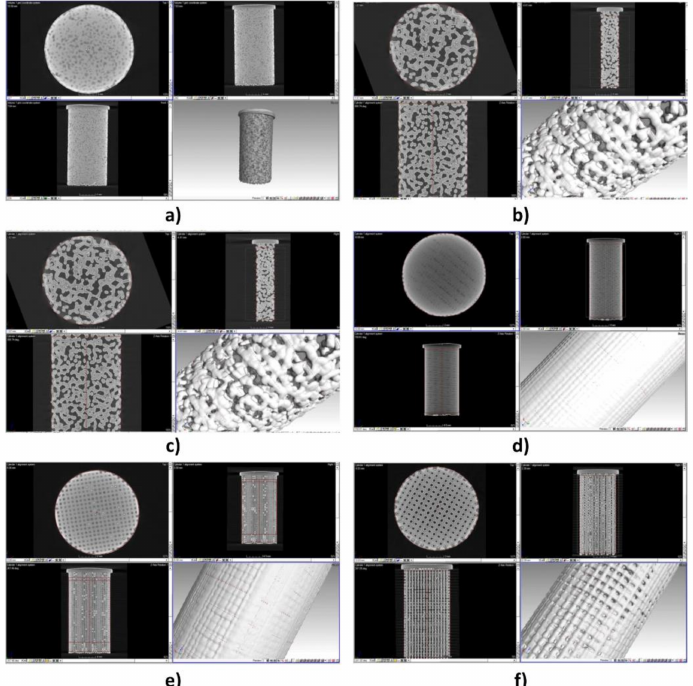
Figure 7. 3D scans of the tested specimens taken by PC-tomography ( a ) trabecular with 200 µ m pore size, ( b ) trabecular with 400 µ m pore size, ( c ) trabecular with 600 µ m pore size, ( d ) cubic with 200 µ m pore size, ( e ) cubic with 400 µ m pore size, ( f ) cubic with 200 µ m pore